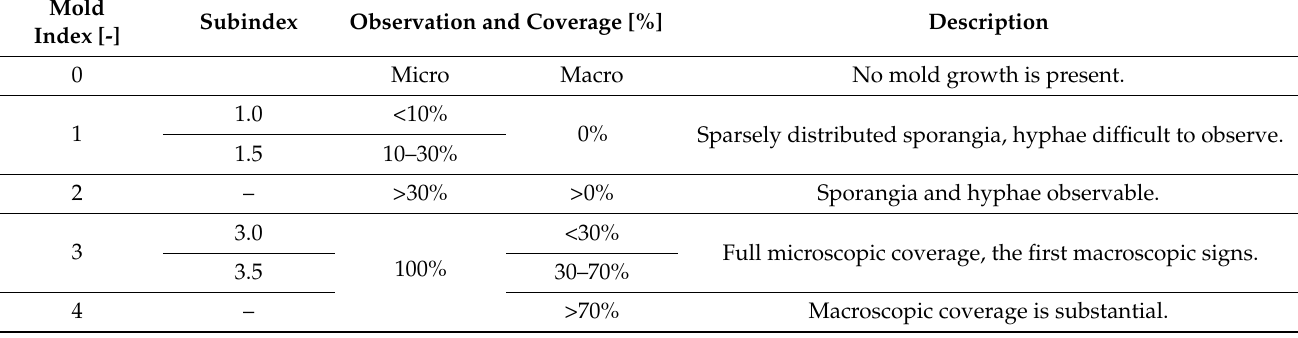
Table 2. Definition of mold growth rating scale.